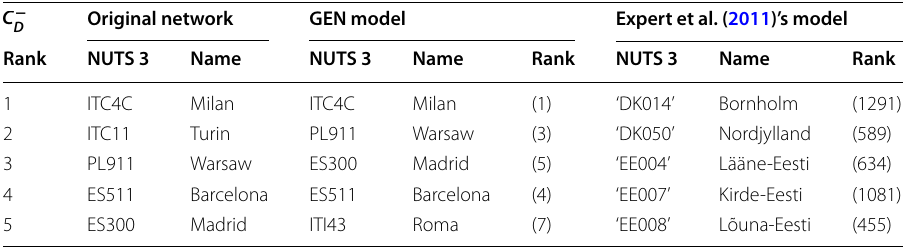
Table 5 In-degree centralities to top 5 NUTS 3 region (2018) C −